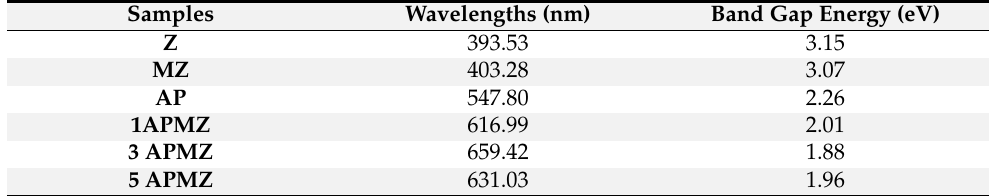
Table 1. The band gap energies comparison among Z, MZ, 1APMZ, 3APMZ, 5APMZ, and AP samples.